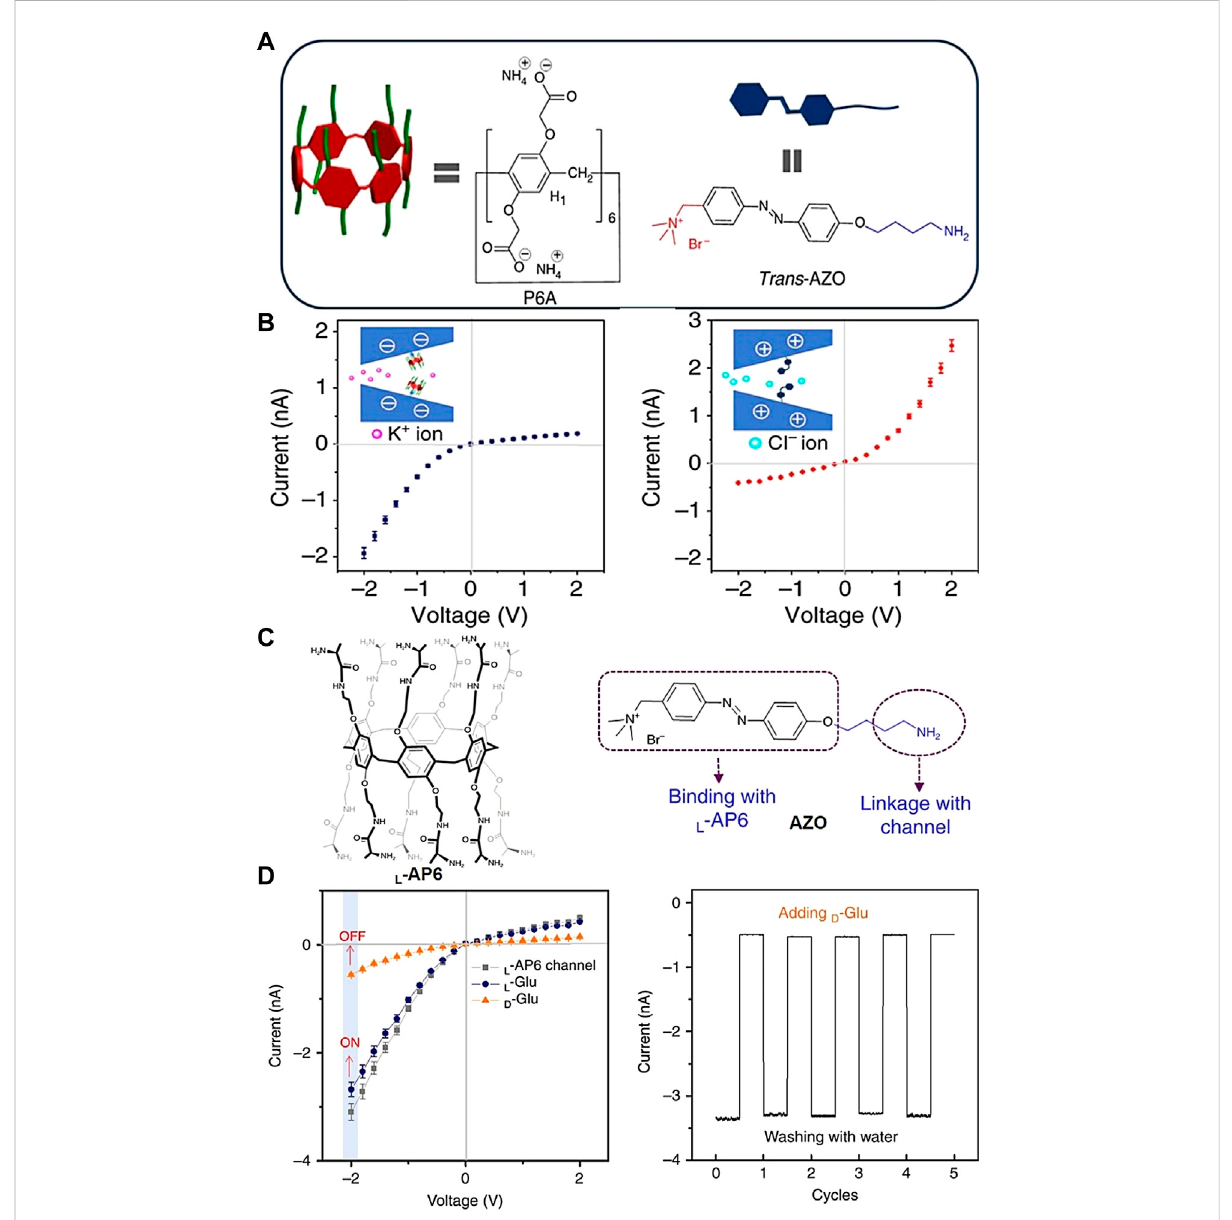
FIGURE 6 (A) Molecular structure diagram of carboxylate-derived pillar[6]arene and quaternary ammonium azobenzene, Copyright @ 2017 (Springer Nature); (B) under visible light irradiation, carboxylate-derived pillar[6]arene-assembled nanochannels showed selective transport behaviors for cations, Copyright @ 2017 (Springer Nature). After irradiated by UV light, quaternary ammonium azobenzene-modi fi ed nanochannels showed selective transport behaviors for anions (Sun et al., 2017); (C) molecular structures of chiral alanine pillar[6]arene and quaternary ammonium azobenzene, Copyright @ 2018 (Springer Nature); (D) D-glucose responds to current changes in ionic-gated nanochannels (Sun et al.,